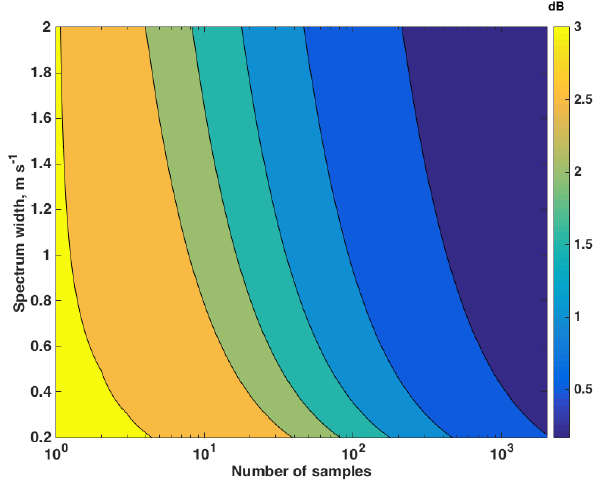
Figure 6. Standard error in reflectivity measurements. For a spec- ified number of samples, standard error in reflectivity becomes lower as the Doppler spectrum becomes broader. For greater than 1000 samples, standard error in reflectivity is > 0.5dB.